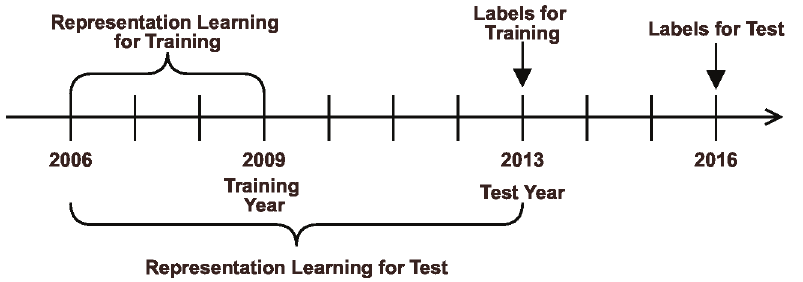
Fig 3. Relation between training period and test period in each index